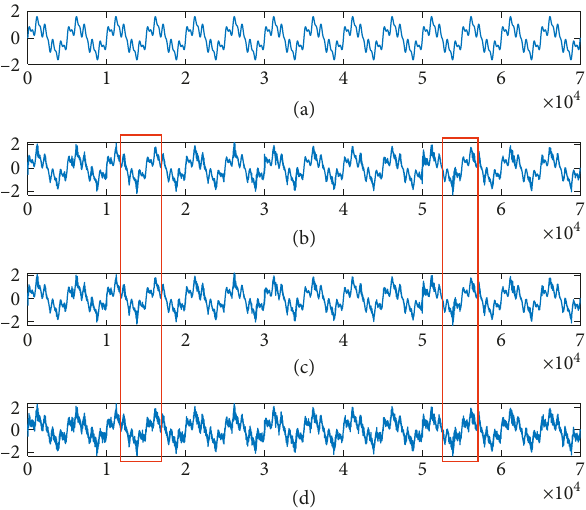
Figure 16: The error signal e with (a) signal mutation when (b) α (d) α (cid:29) 0.5 (cid:29)